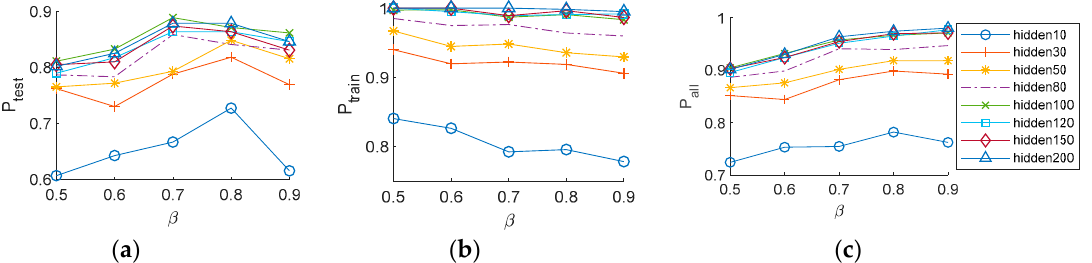
Figure 8. The curve of accuracy changing with training set ratio β when CNN takes different number of hidden nodes. The horizontal axis in the figure represents the proportion of the number of training images to the total number of images. The vertical axis represents the recognition accuracy: ( a ) The accuracy of the test set; ( b ) The accuracy of the training set; ( c ) The accuracy of all images.